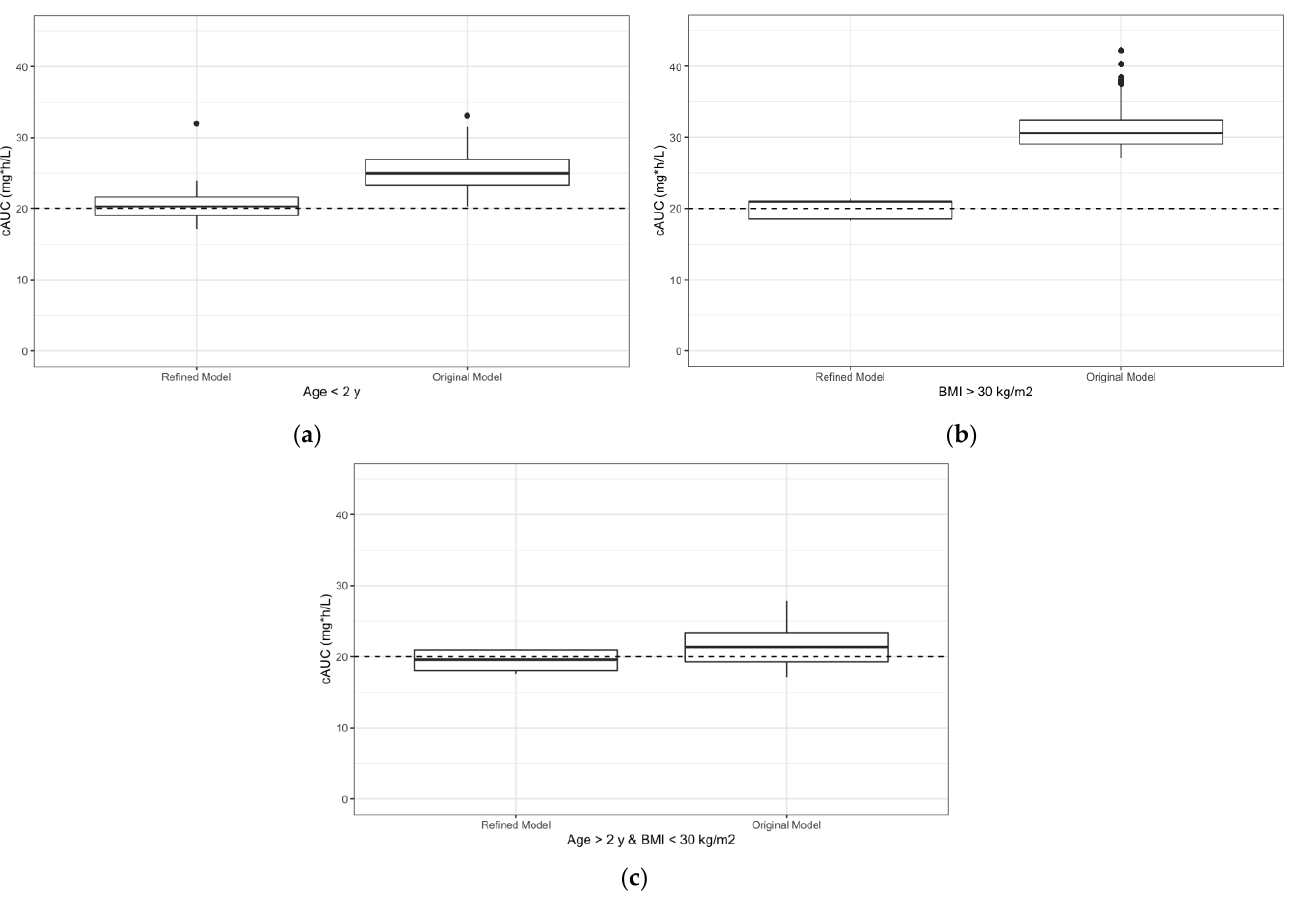
Figure 3. Maturation function factor on f-ara-a CL (left axis, circles) and CrCL factor on f-ara-a CL (right axis, triangles) over age in years of the combined data set used to refine the model. CrCL factor does account for age-related maturation of CL of f-ara-a.